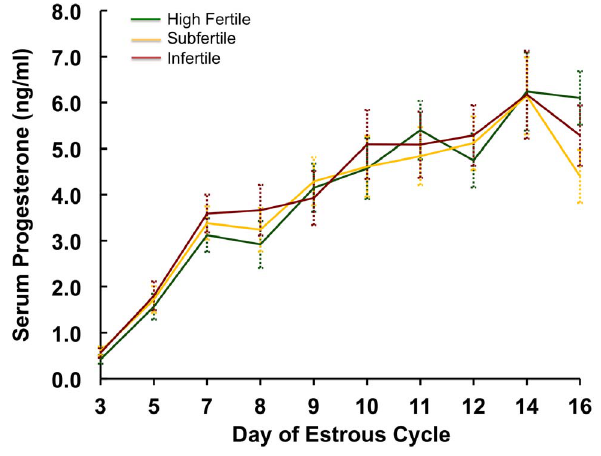
Figure 2. Circulating concentrations of progesterone in a subset of fertility classified heifers after ovulation. Note the lack of difference in serum progesterone levels in high fertile (HF, n=13), subfertile (SF, n=12) and infertile (IF, n=10) heifers.